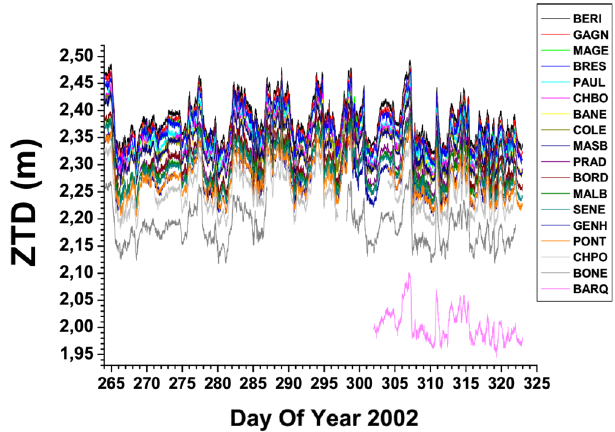
Fig. 10. ZTD time series for the 18 stations of the local network over the total observation span (doy 264 to 325 of